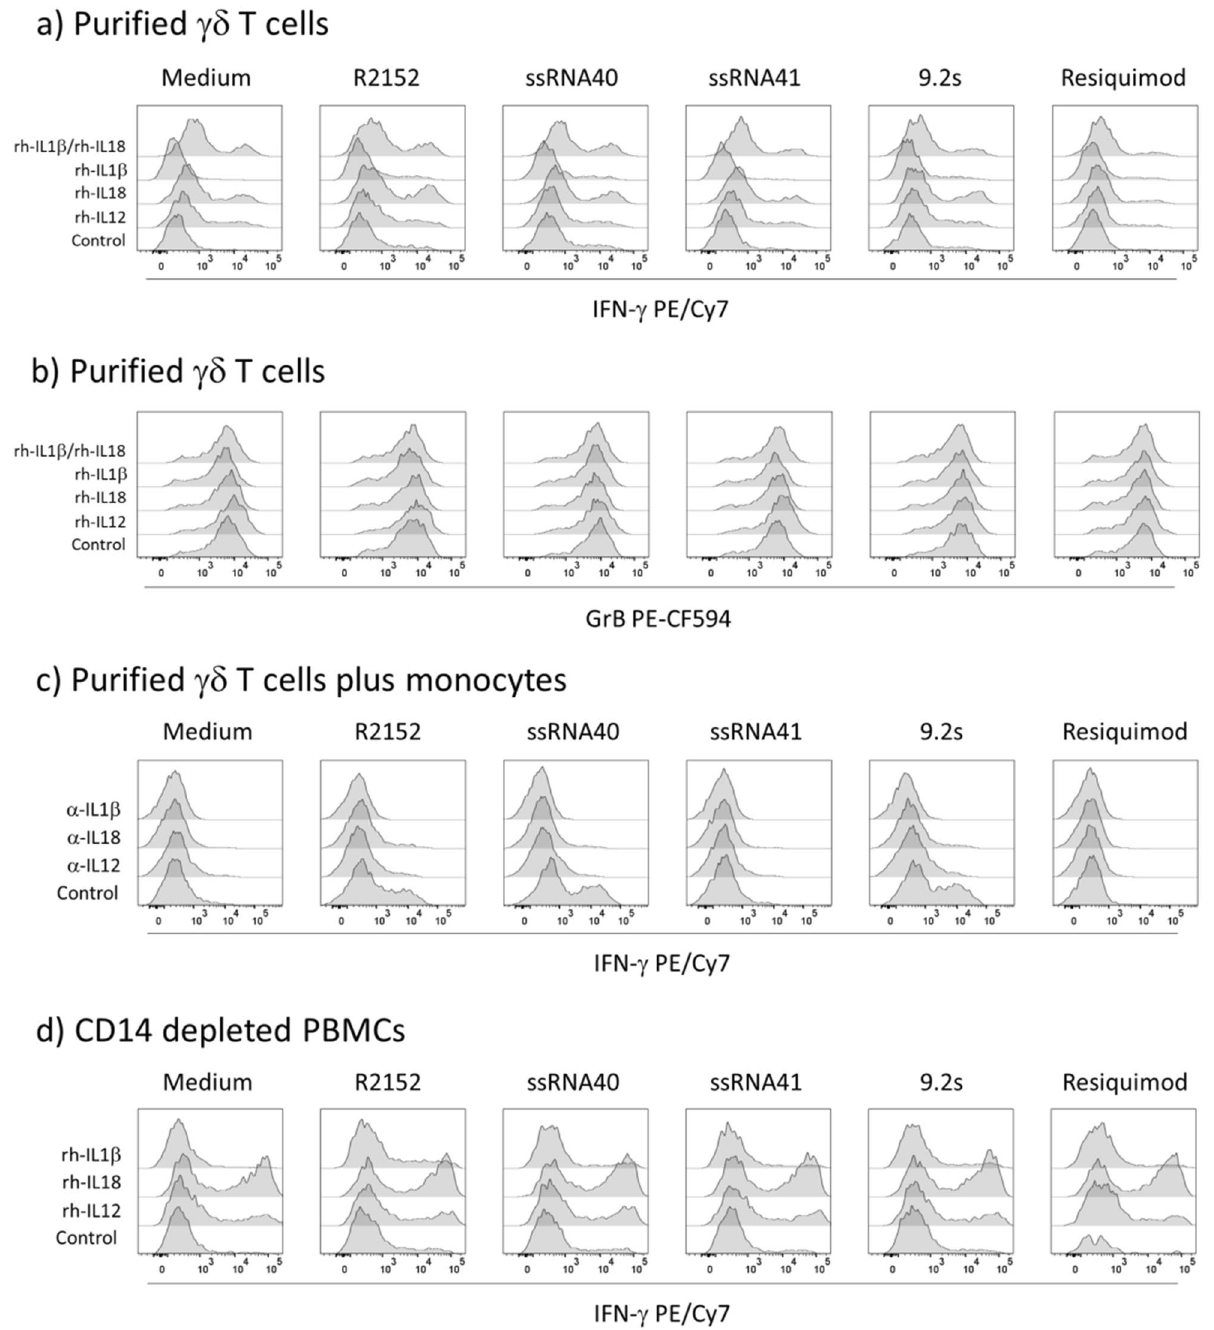
Figure 5. Role of monocytes in co-stimulation of γδ T cells by TLR8 ligands. 100.000 purified γδ T cells alone ( a , b ), or together with 100.000 purified monocytes ( c ), or 400.000 CD14-depleted PBMC ( d ) were activated with HMBPP in the presence or absence of TLR8 ligands as indicated. Recombinant cytokines IL-1β (10 ng/ mL), IL-12 (10 ng/mL), IL-18 (20 ng/mL ( a , b , d ) or 5 µg/mL of neutralizing anti-cytokine antibodies ( c ) were added as indicated. Intracellular expression of IFN-γ (a,c,d) and GrB ( b ) in CD3 + Vδ2 + γδ T cells was analyzed after 24 h. The lower histograms in each panel show the IFN-γ/GrB expression in the absence of added cytokines ( a , b , d ) or anti-cytokine antibodies ( c ). Histograms of one representative out of five ( a , b , c ) or two ( d ) experiments are